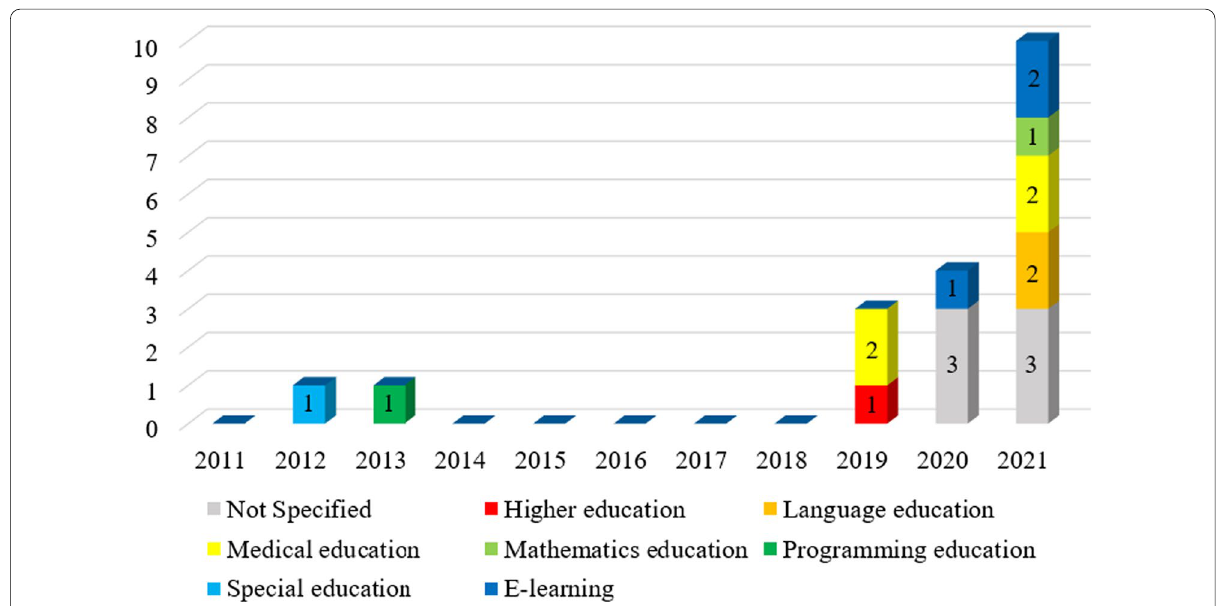
Fig. 1 Existing literature review of AIEd articles, ranging from 2011 to